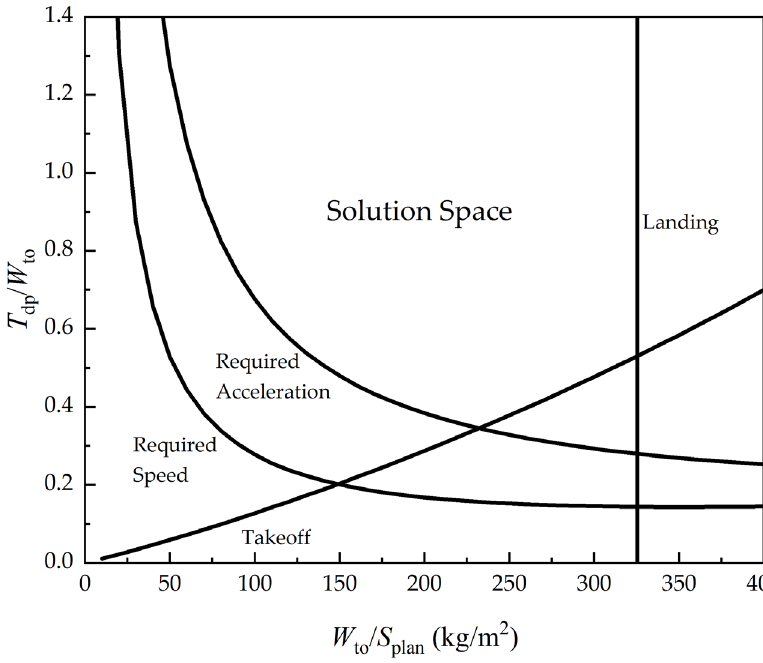
Figure 4. An illustration of the constraint analysis diagram.